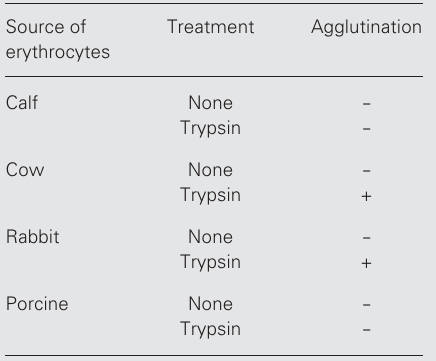
Table 1. Binding of various types of erythrocytes to cat liver galectin.